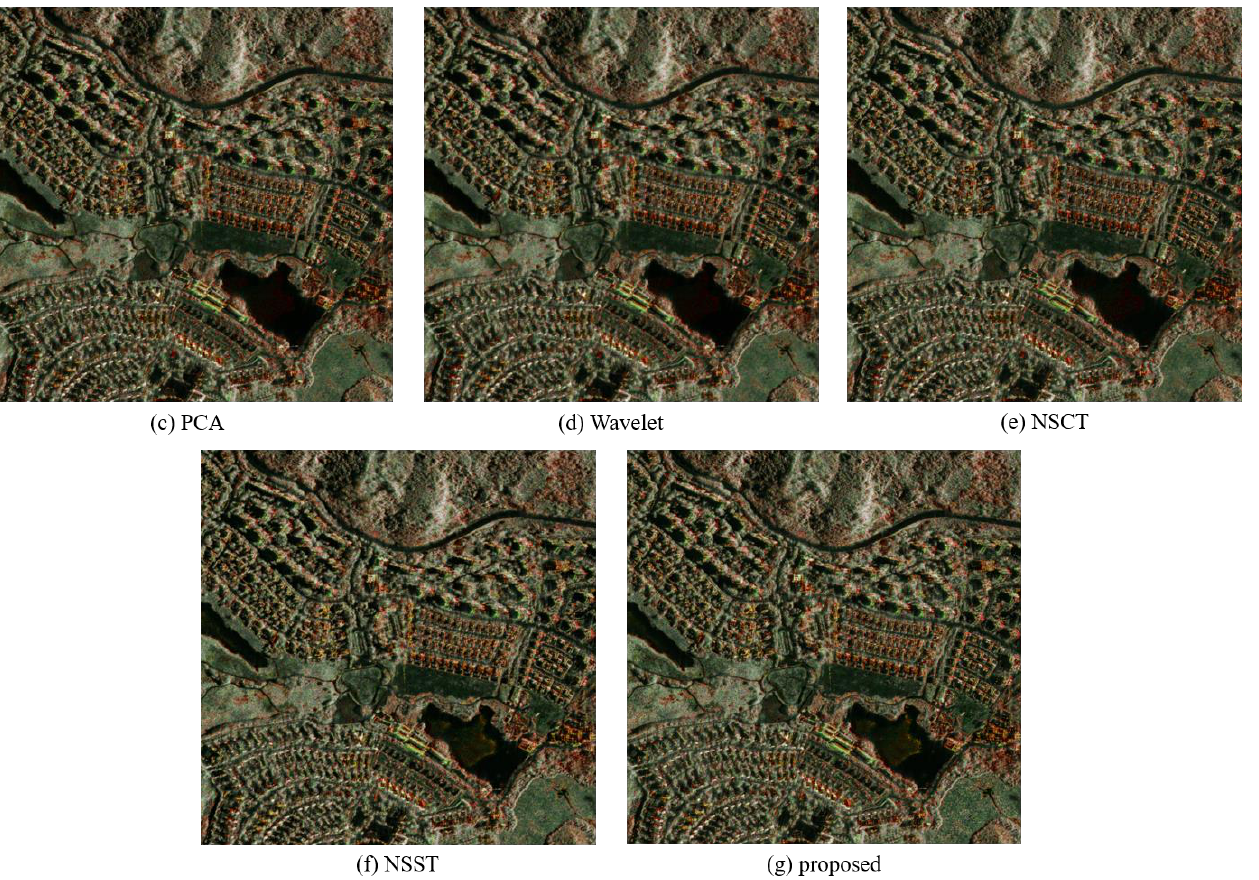
Figure 12. Complete colorization fusion results of scene 2: ( a ) Band difference map; ( b ) polarization difference map; ( c ) PCA fusion; ( d ) wavelet fusion; ( e ) NSCT fusion; ( f ) NSST fusion; and ( g ) proposed method fusion.